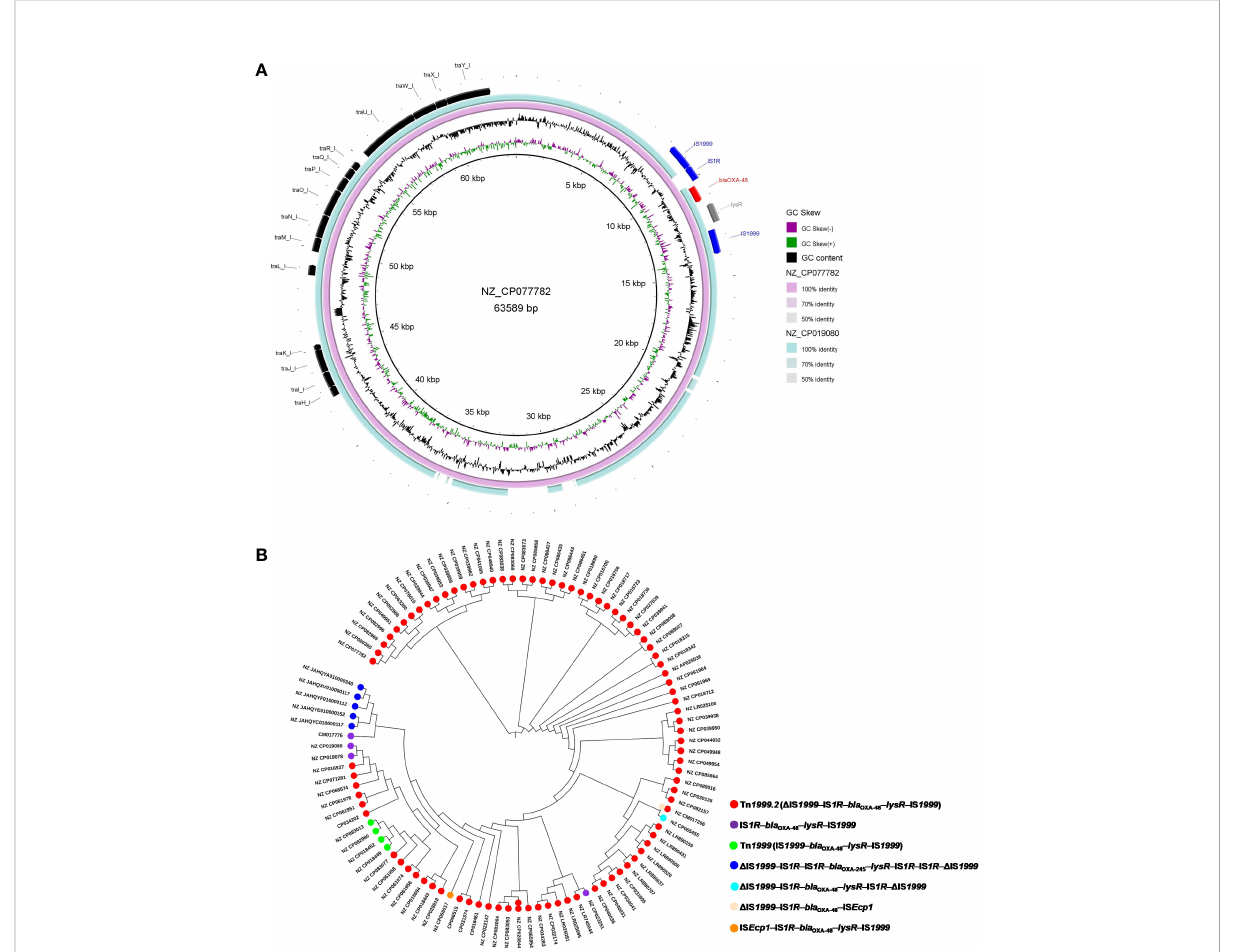
FIGURE 3 An overview of the conjugative transfer regions and genetic environment surrounding bla OXA-48 or bla OXA-245 carried by the 102 IncL/M-type plasmids classi fi ed into the clade I cluster. (A) Details of the Tra_I-like T4SS gene clusters, transposon Tn 1999.2 , and Tn 1999 in the representative plasmids. (B) Distribution of different genetic contexts surrounding bla OXA-48 -like genes in the 102 IncL/M-type